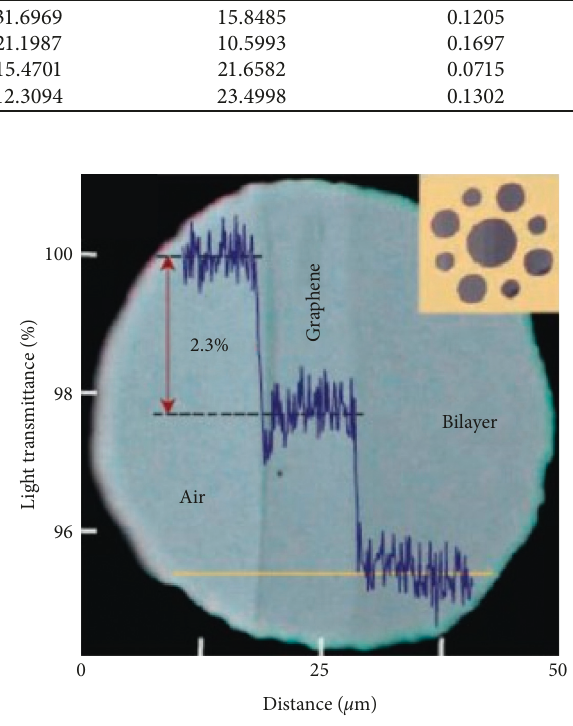
Figure 6: 50 μ m aperture of photograph with partially covered using graphene and its bilayer.